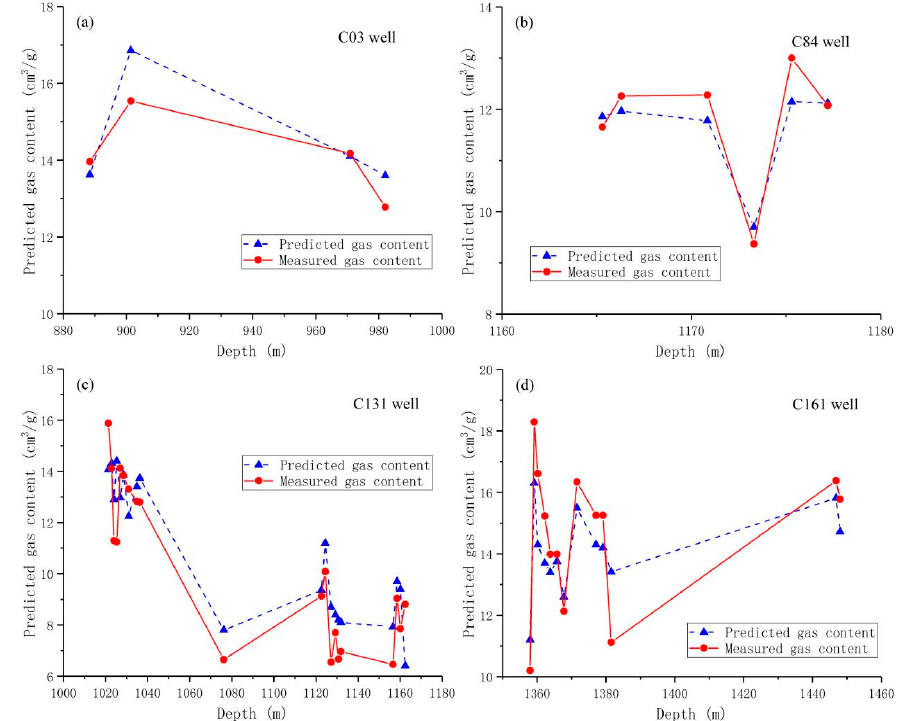
Figure 2. Comparison between predicted and measured gas contents with Kim method in the C03 well ( a ), C84 well ( b ), C131 well ( c ), and C161 well ( d